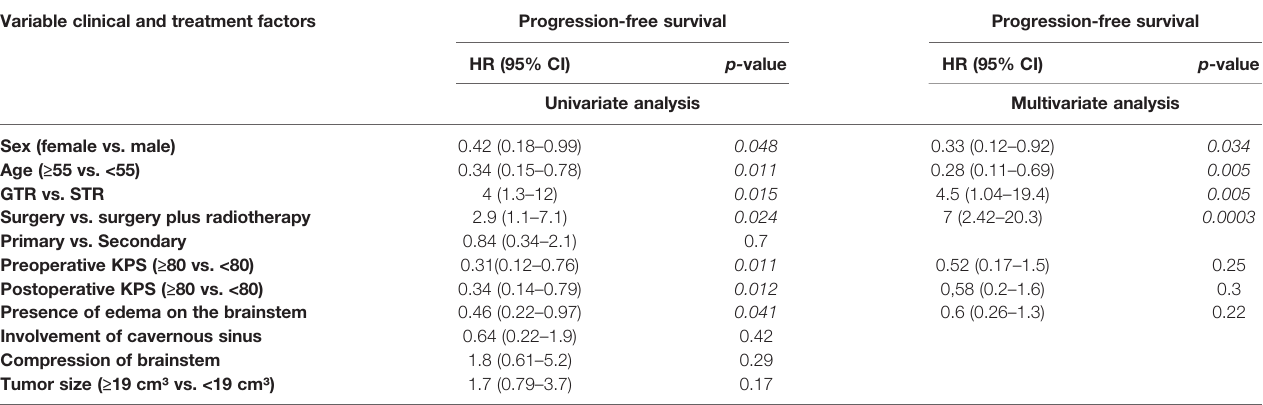
TABLE 2 | Cox-regression analysis of all patients. Variable clinical and treatment factors Progression-free survival